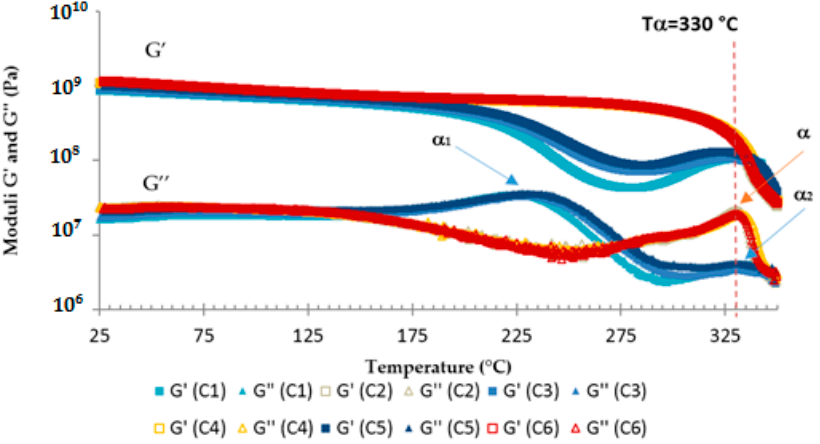
Figure 16. Rheological analyses of TETM/DDS formulations cured according to various cure cycles.